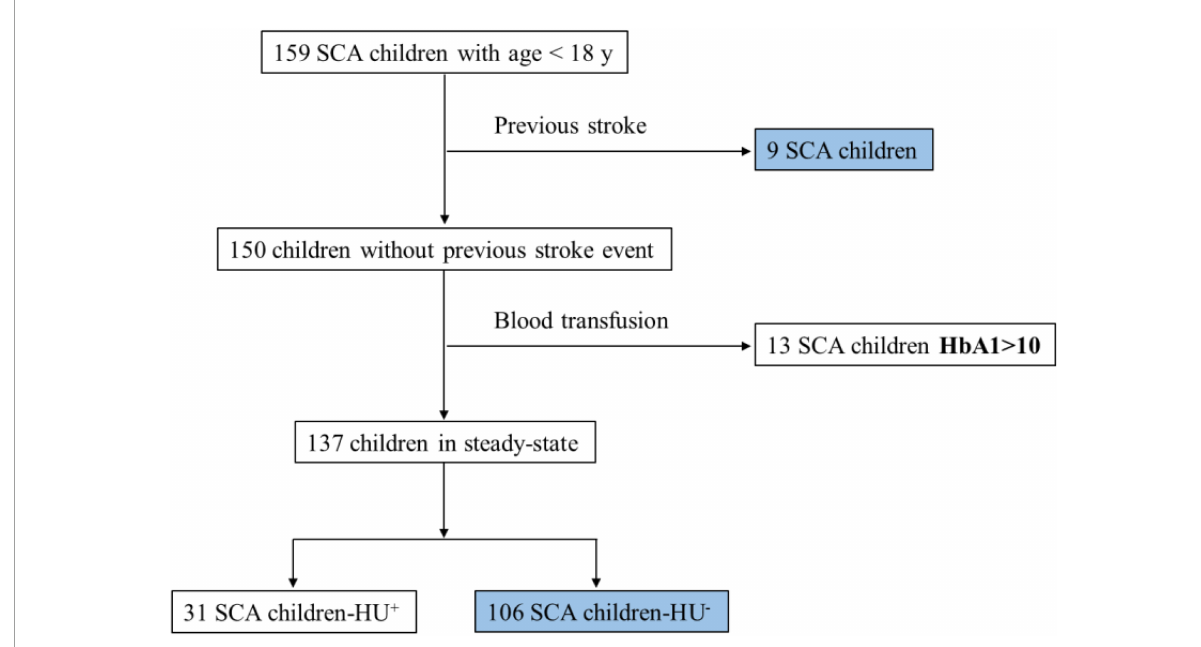
FIGURE1 Study design. SCA, sickle cell anemia; HU + , with HU treatment; HU-, without HU treatment; y, years.